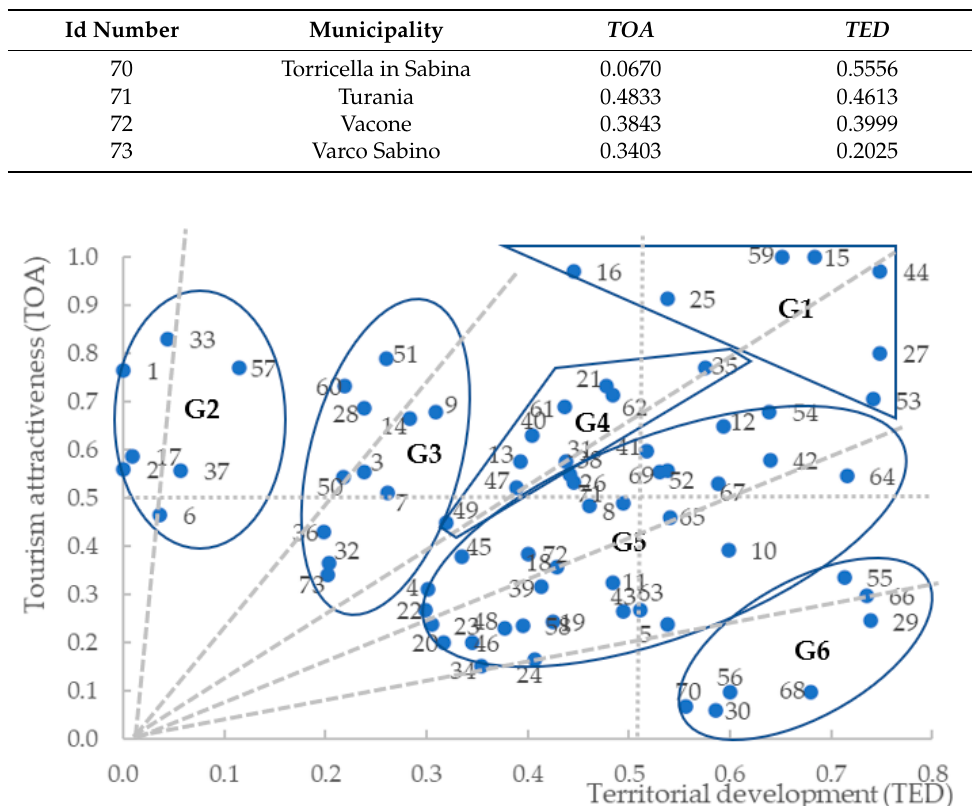
Figure 1. Tourism attractiveness and territorial development of the municipalities in the Province of Rieti: a scatterplot analysis. Author’s own figure.